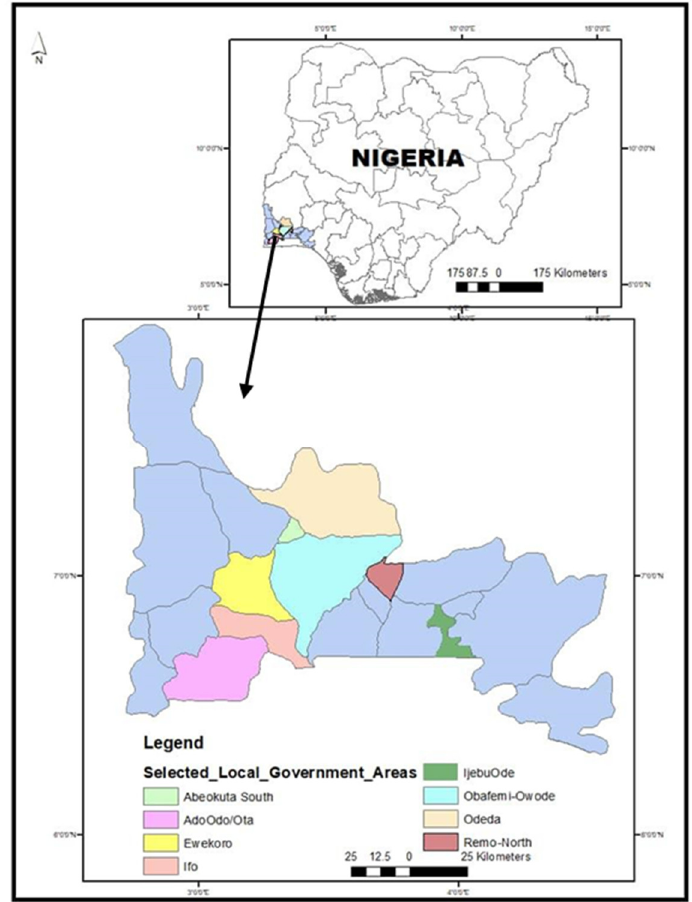
Figure 1. Spatial distribution of local government areas covered in Ogun State.